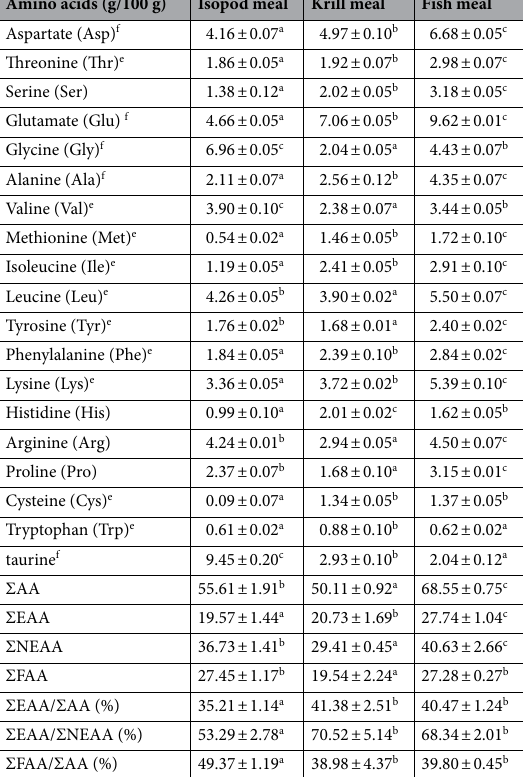
Table 2. Amino acids composition of isopod meal, antarctic krill meal and fish meal (%, dry weight). ΣAA is total amino acids, ΣEAA is total essential amino acids, Σ NEAA is total nonessential amino acids, and ΣFAA is total flavor amino acids. Amino acids marked e means essential amino acids, while f means flavor amino acid. Numerical values marked with the same letter a,b or c are not statistically significantly